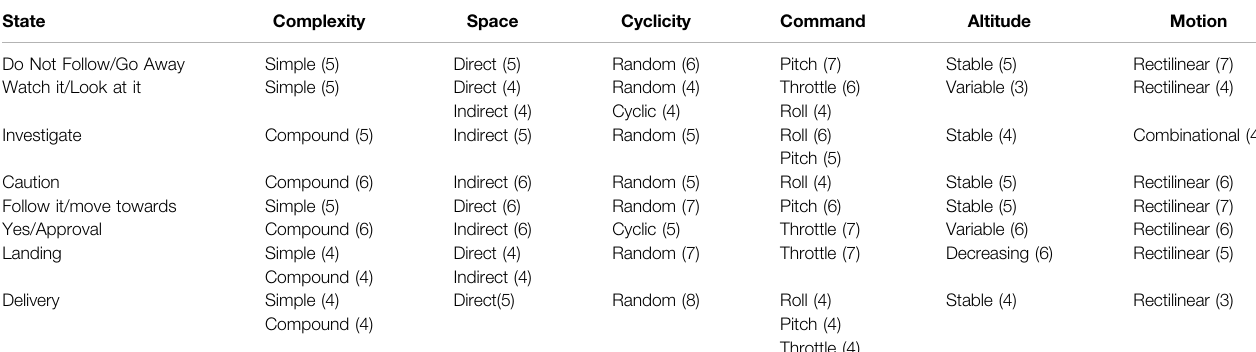
TABLE 8 | Motions created in Phase 4 classi fi ed according to the taxonomy and labeling from (Firestone et al.,